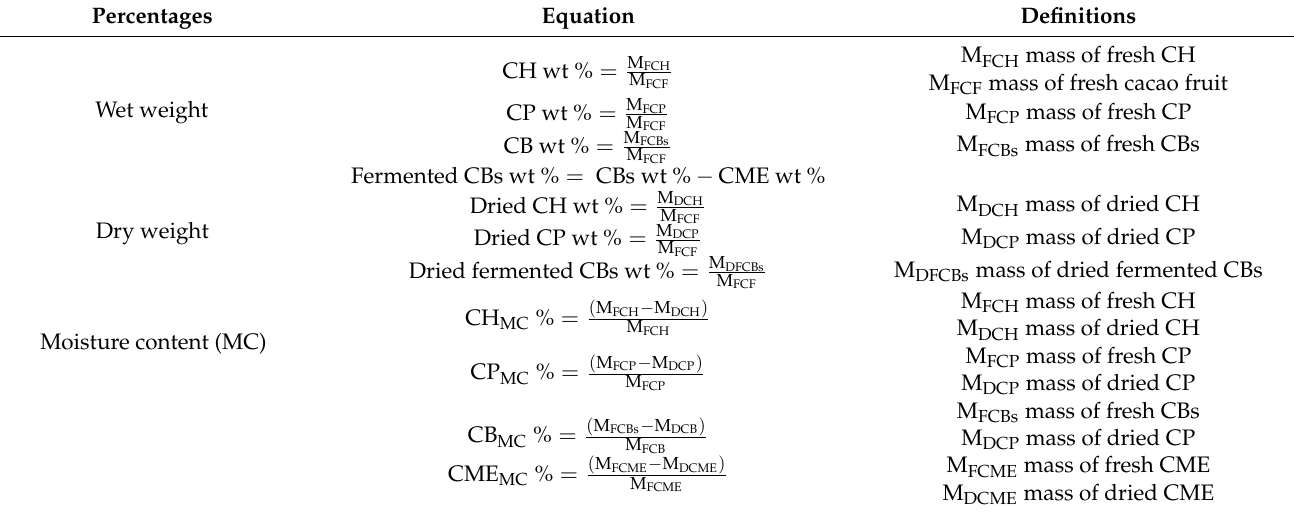
Table 7. Equations used to determine the percentages by weight of cacao fruit